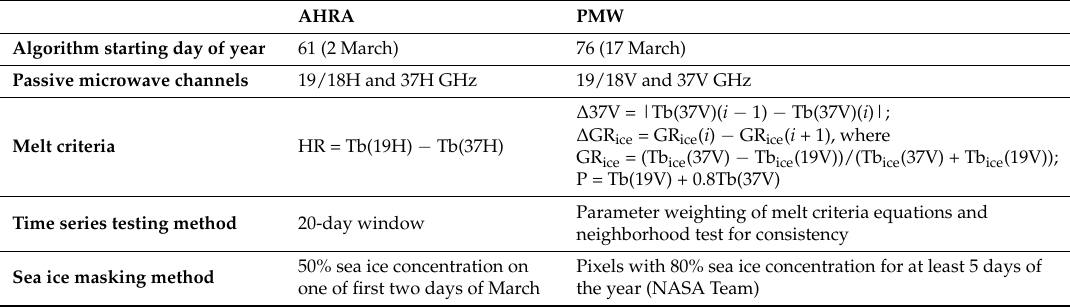
Table 1. MO algorithm summary 1